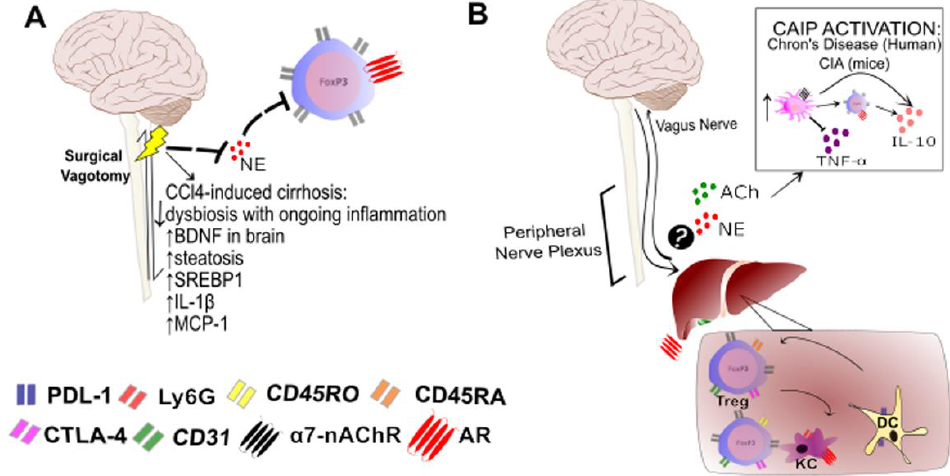
Figure 1. Possible influence of the nervous system on the liver immune system after liver transplan- tation. ( A ) Among the interactions of neurotransmitters in liver injury by CCl 4 -induced cirrhosis, a decrease in norepinephrine (NE) is observed after sympathectomy, followed by a decrease in regulatory T cell (Treg) and increases in inflammatory cytokines, such as interleukin (IL)-1 β and monocyte chemoattractant protein-1 (MCP-1), in addition to increases in hepatic steatosis and brain inflammation markers. ( B ) Collectively, evidence for neuroendocrine-immune interactions in the liver, mainly collected in clinical trials, shows that, after liver transplantation (LT), the Treg cell pool is heterogeneous and may present phenotypes indicative of different origins. Thus, these cells may express CD45RO or CD45RA, in addition to presenting CD31 on the cell surface. In addition, dendritic cells (DCs) contribute to the regulatory microenvironment, leading to a tolerogenic response after LT. In the peritoneal microenvironment, it is possible that these cells are modulated by β -adrenergic receptors in Kupffer cells (KC) via NE, as observed in other conditions associated with the peritoneal microenvironment or acetylcholine (ACh) release induced by cholinergic anti-inflammatory pathway (CAIP) activation. These changes are able to induce the anti-inflammatory macrophage profile via Treg cells and thus modulate the inflammatory response. BNDF: brain-derived neurotrophic factor; SREBP1: sterol regulatory element-binding protein-1; PDL-1: programmed death-ligand 1; CTLA-1: cytotoxic T-lymphocyte-associated antigen 4; α 7nAChR: alpha7-nicotinic acetylcholine receptor; AR: adrenergic